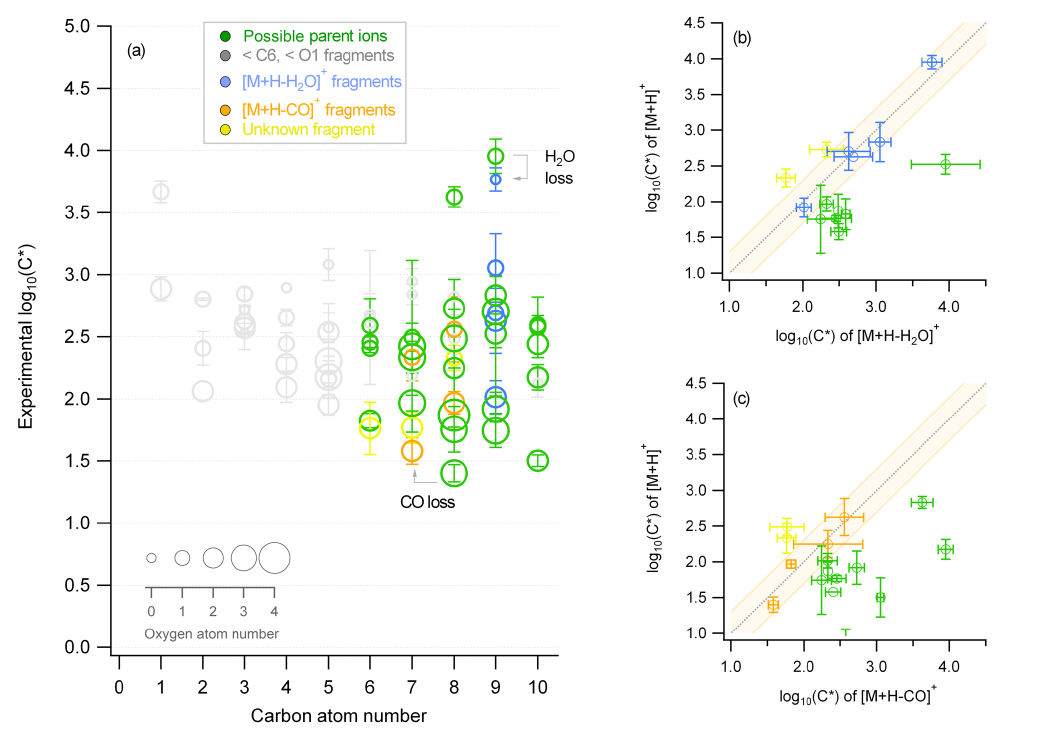
Figure 1. Characteristic example of the fragment identification method from the β -pinene ozonolysis experiment for the ACM where (a) is the experimental saturation concentration ( y axis) for all identified compounds with different carbon ( x axis) and oxygen atom number (size of markers). Different colors indicate whether the compound represents a possible parent ion (green), a fragment with a carbon and oxygen atom number lower than 6 and 1, respectively (grey), or a fragment originating from the loss of water (blue) or CO (orange). This attribution results from panels (b) and (c) , which show the correlation of the saturation concentration of identified ( M + H ) + ions to compounds with the same chemical formula subtracting water ( M + H − H 2 O ) + or CO ( M + H − CO ) + . If the correlation is close to the 1 : 1 line, then the ( M + H − H 2 O ) + or ( M + H − CO ) + compound is identified as a fragment and is given the respective color (blue or orange). If the ( M + H − H 2 O ) + or ( M + H − CO ) + compound shows a higher volatility, it is considered as a possible parent ion (green). The orange background indicates the ± 0 . 25 change in log( C ∗ ). Error bars correspond to the error of the average ( ± 1 σ